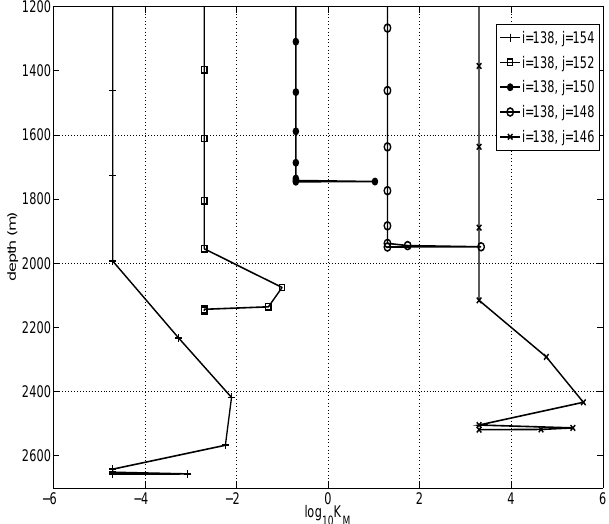
Fig. 13. Profiles of the coefficient of vertical diffusion of momen- tum, K M (m 2 s − 1 ). Profiles are offset as in Fig. Fig.13. Profilesof thecoefficient of vertical diffusionof momentum, K M [ m 2 /s ] . Profilesareoffset asinFig. 8.